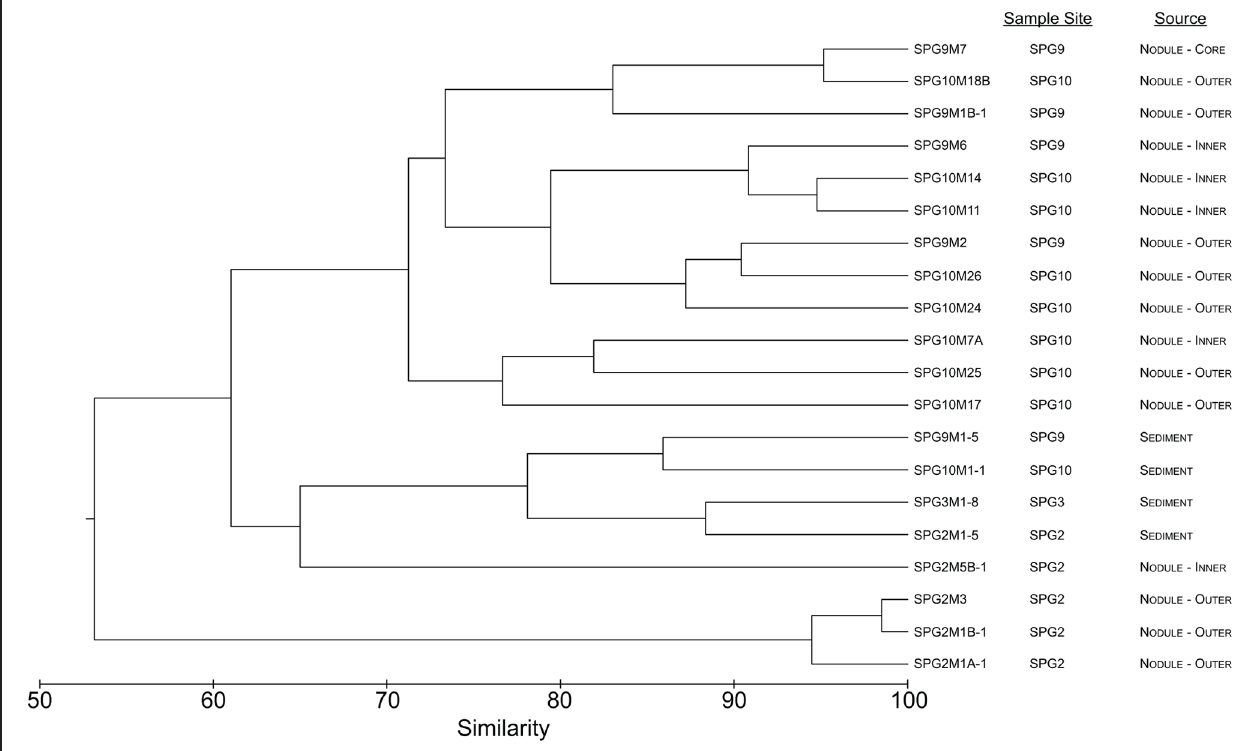
FIGURE 1 | Dendrogram representing the community similarity of the 20 different sediment and nodule samples using the θ YC calculator in the mothur package. Samples are classified by sample site and